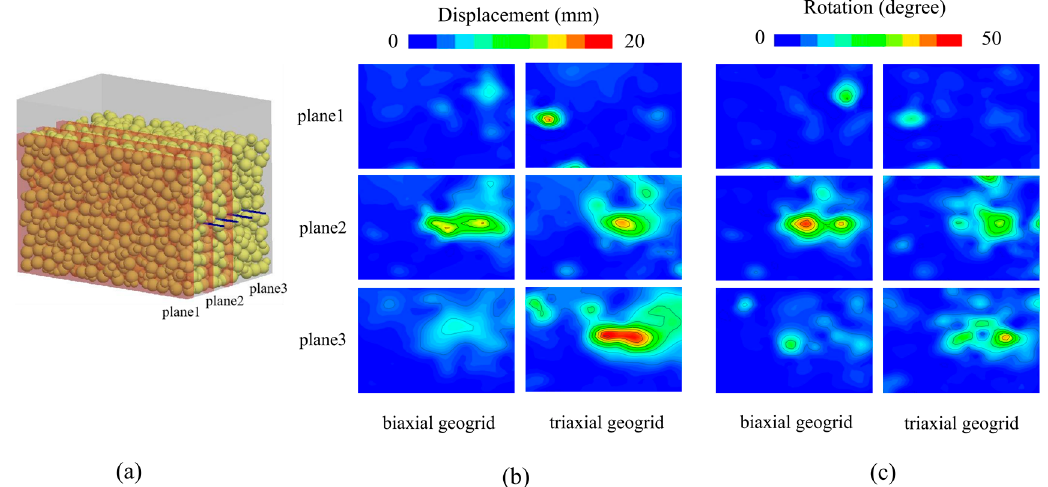
Figure 11. Particle displacement and rotation contours: ( a ) three sections of sample; ( b ) particle displacement and ( c ) particle rotation .